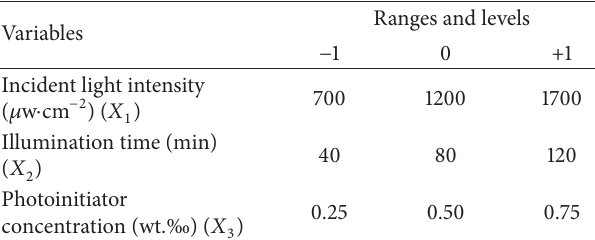
Table 1: Experimental ranges and levels of the independent test variables.